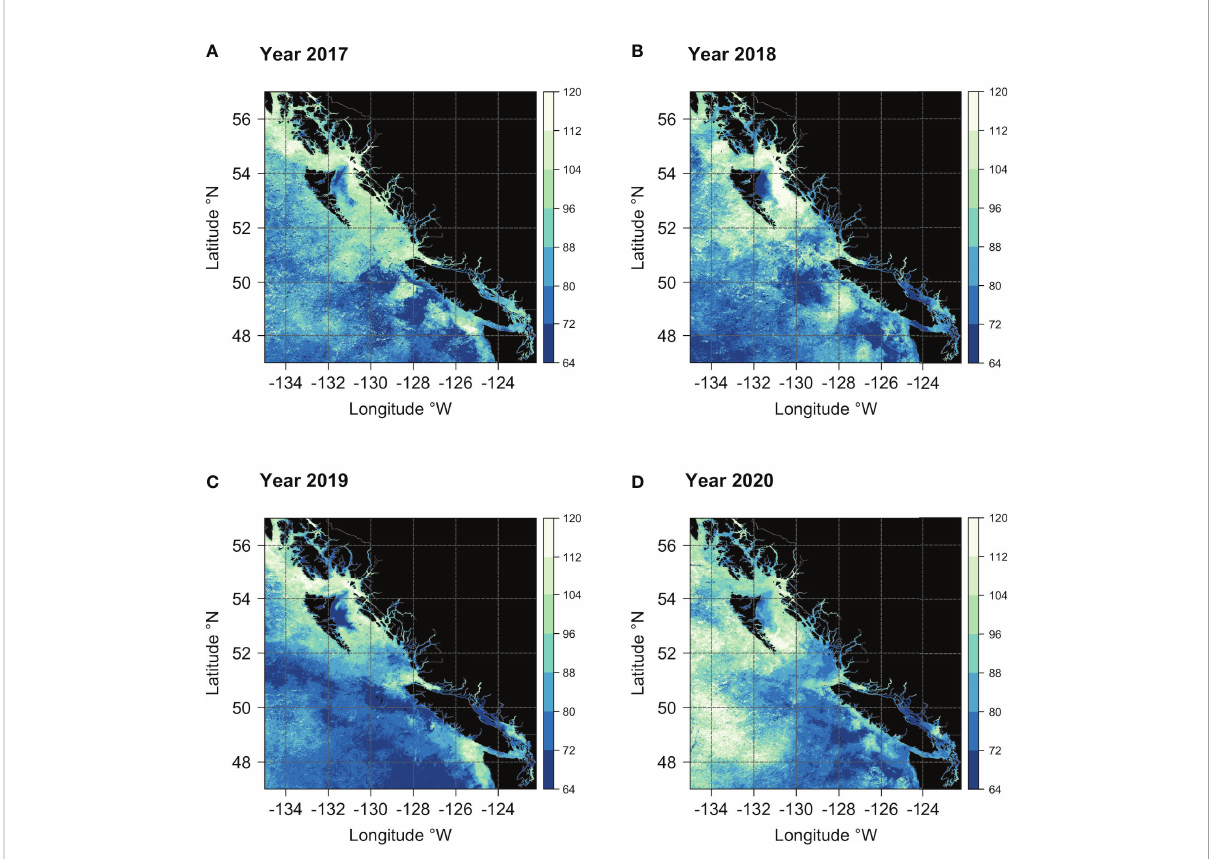
FIGURE 9 Maps showing the spring bloom onset dates across the study area for the years (A) 2017, (B) 2018, (C) 2019, and (D) 2020. The vertical color bar indicates the day of the year (DOY), with colors ranging from dark blue (early bloom) to white (late